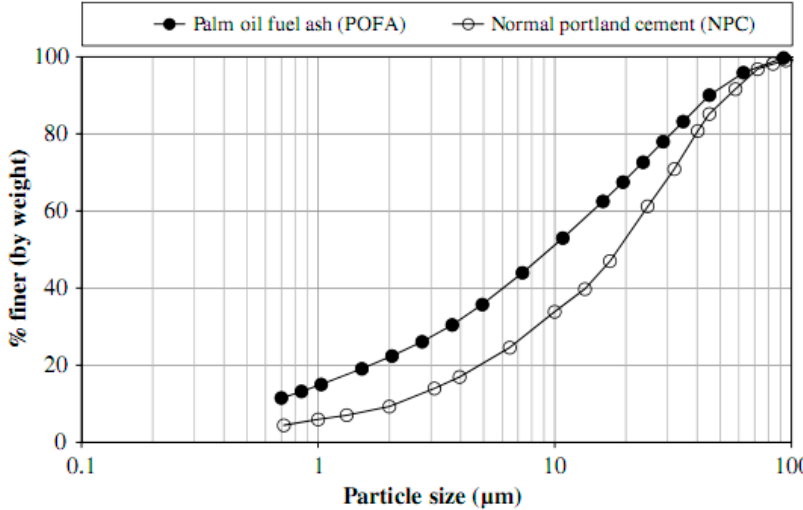
Figure 8. Particle size distributions of OPC and POFA [23,94]. Reprinted with permission from Elsevier [23,94].